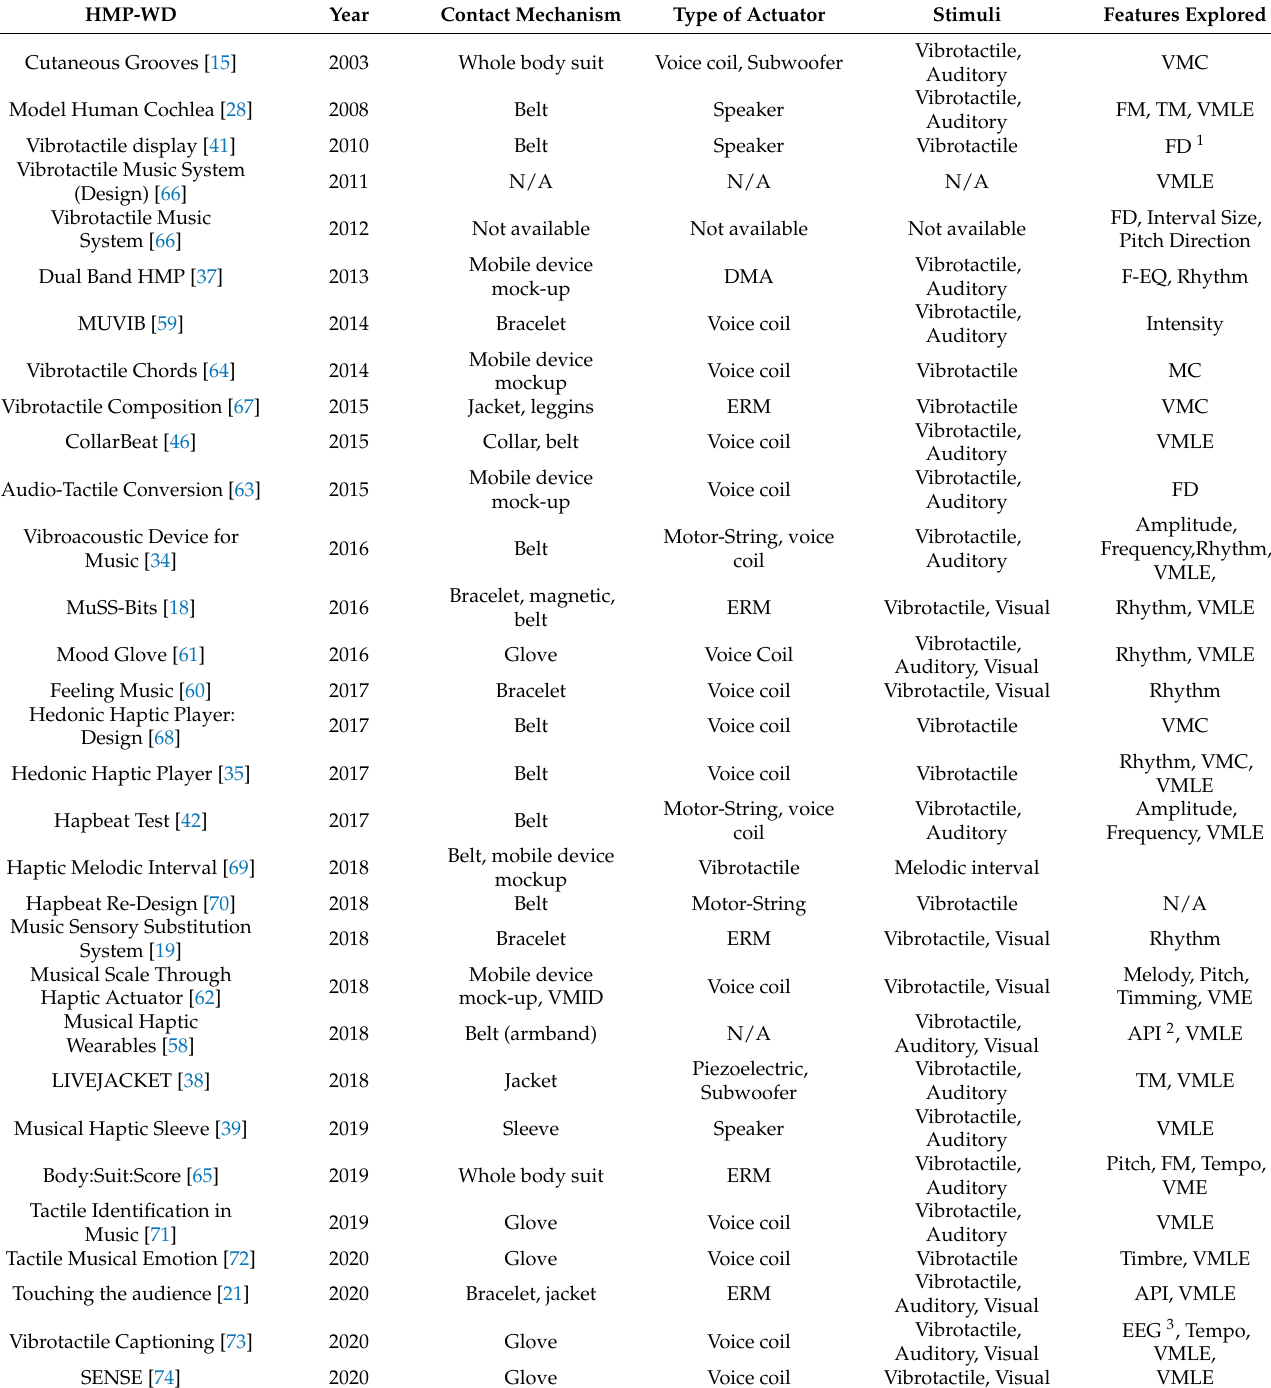
Table 3. Overview of research on haptic music player-wearable devices